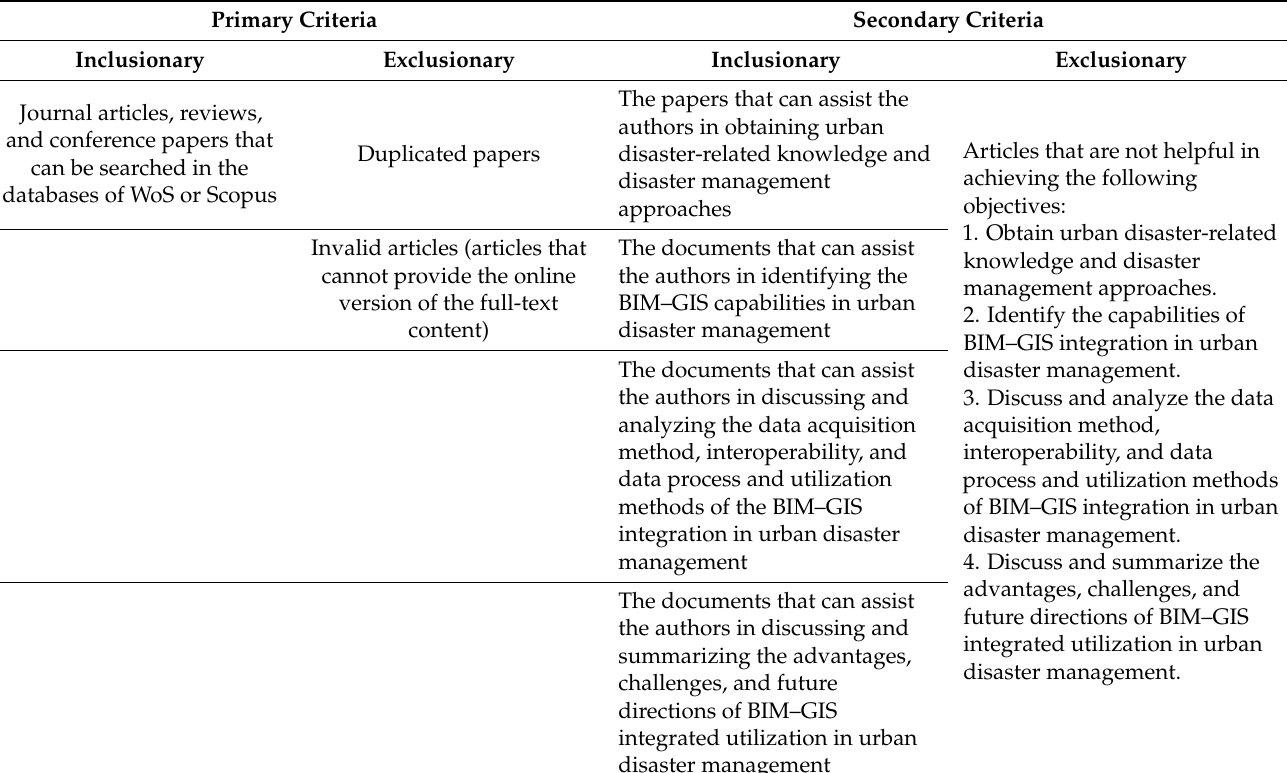
Table 1. Inclusion and Exclusion Criteria.